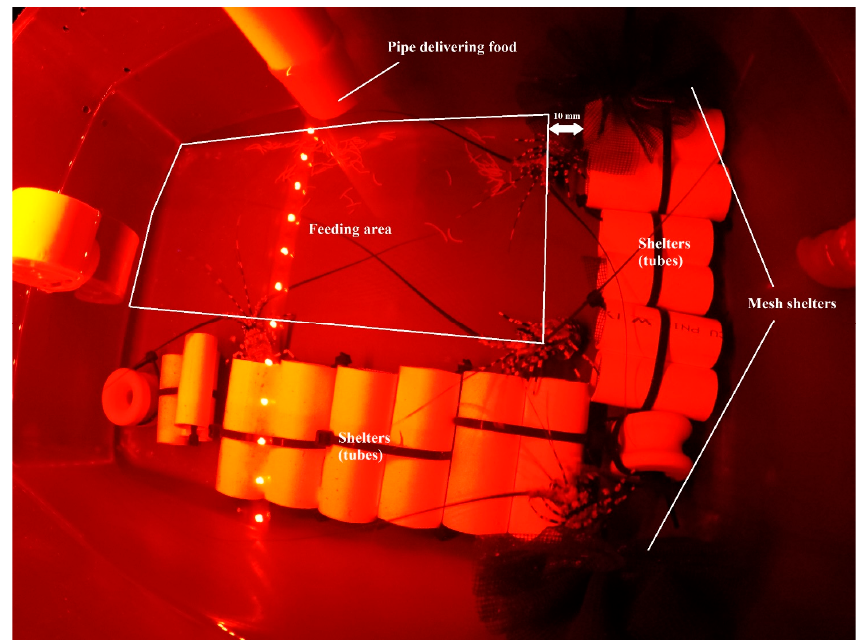
Figure 1. Plan of experimental vessel floor, showing distribution of shelters, location of pipe deliv- ering food and feeding area.